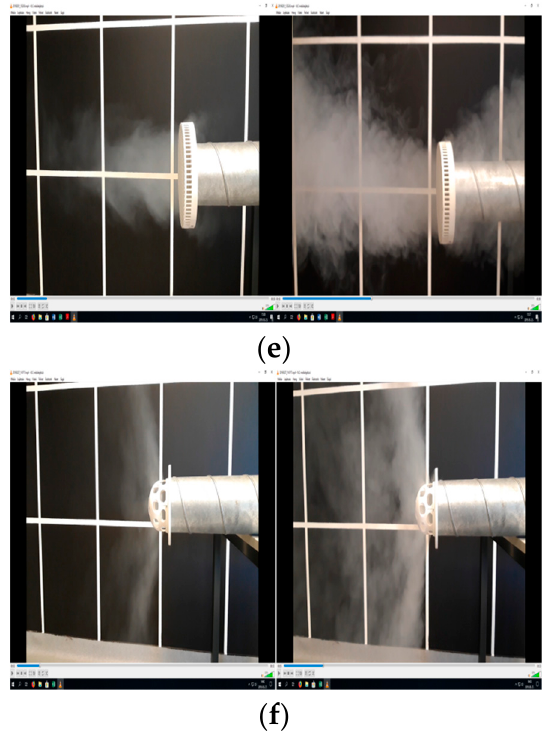
Figure 9. Visualization of air flow with smoke tests: ( a ) D = 100 mm air duct. ( b ) SAR circular perforated ATD, ( c ) KV 100, ( d ) E50/100, ( e ) TSP 100, and ( f ) closed ZMD type ATD.